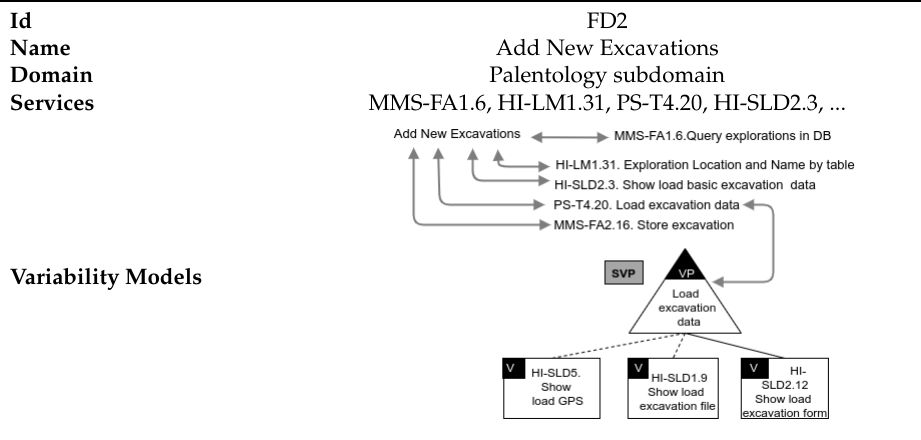
Table 2. An example of the functional datasheet for Add New Excavations (extracted from [38]).